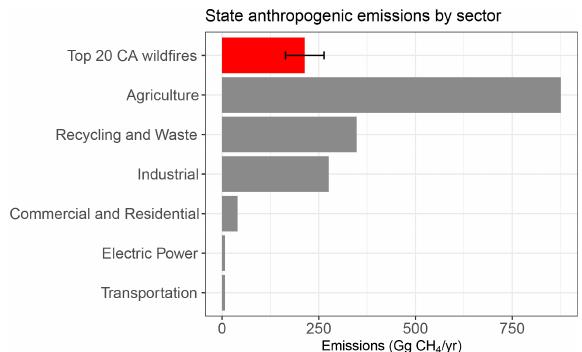
Figure 8. California CH 4 emissions from 2020 calculated for the top 20 wildfires of 2020 compared to the state’s anthropogenic CH 4 emissions from the 2020 inventory (CARB, 2022b). The industrial sector also includes oil and gas